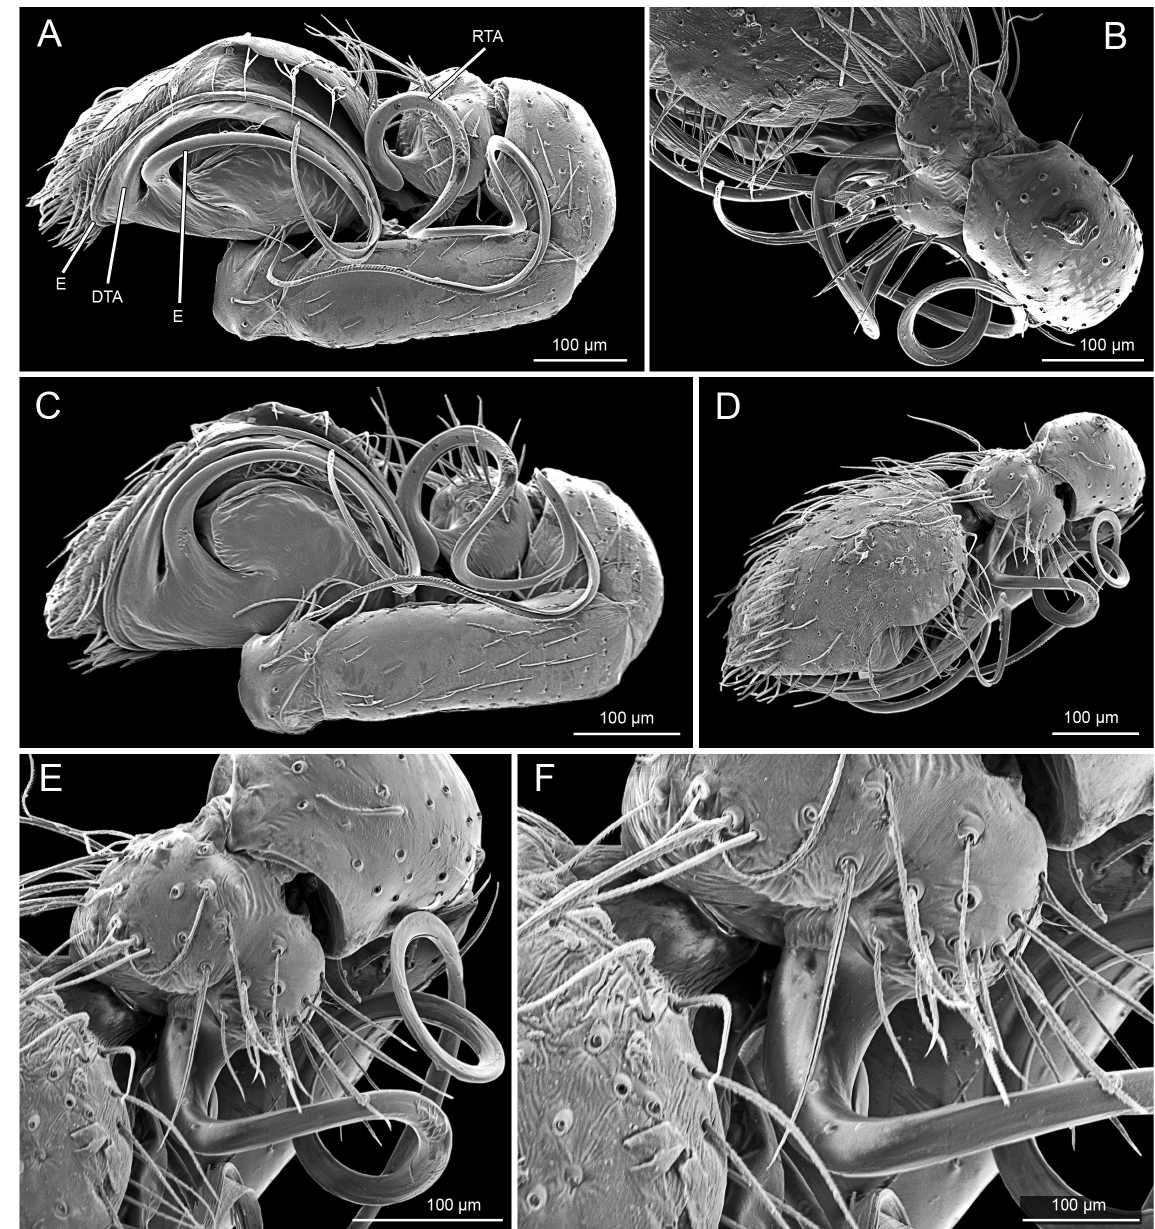
Fig. 4. Hortipes gigapophysalis sp. nov. A . Male palp, retrolateral view. B . Male palpal patella and tibia, dorsal view. C . Male palp, ventral view. D . idem, dorsal view. E . Male palpal tibia and patella, dorsolateral view. F . detail of previous. e: embolus, dTa: distal tegular apophysis, RTa: retrolateral tibial